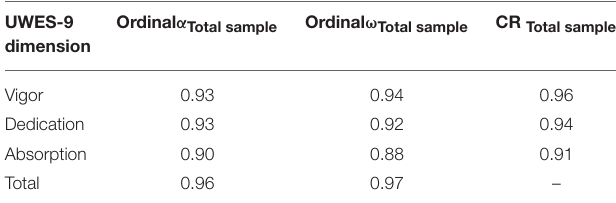
TABLE 5 | Internal consistency of UWES